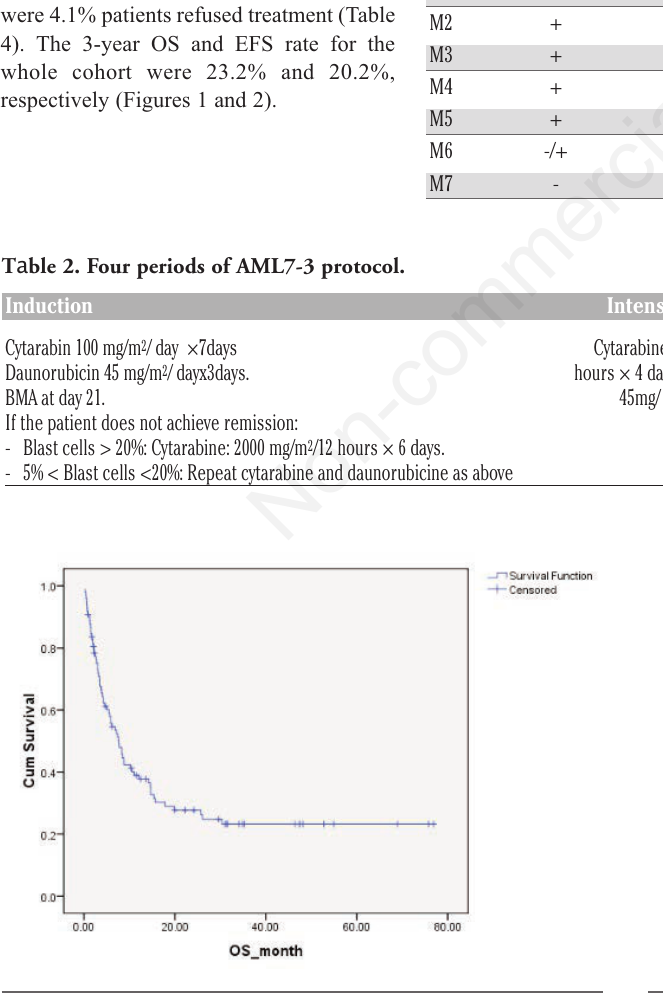
Figure 1. Overall survival curve. Figure 2. Even free survival